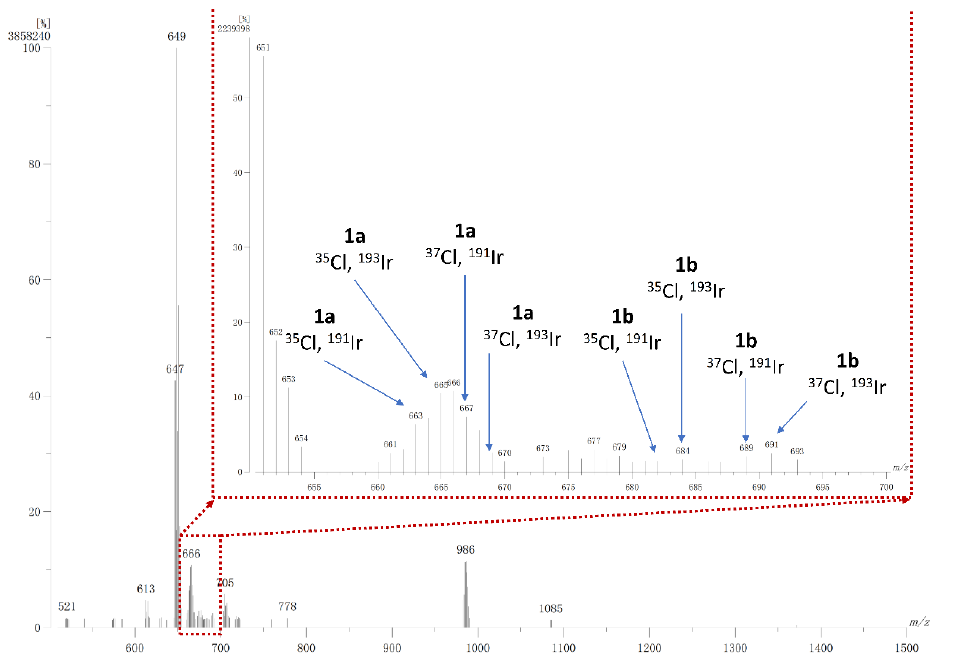
Figure 5. Mass spectrum of 1 with fast atom bombardment.